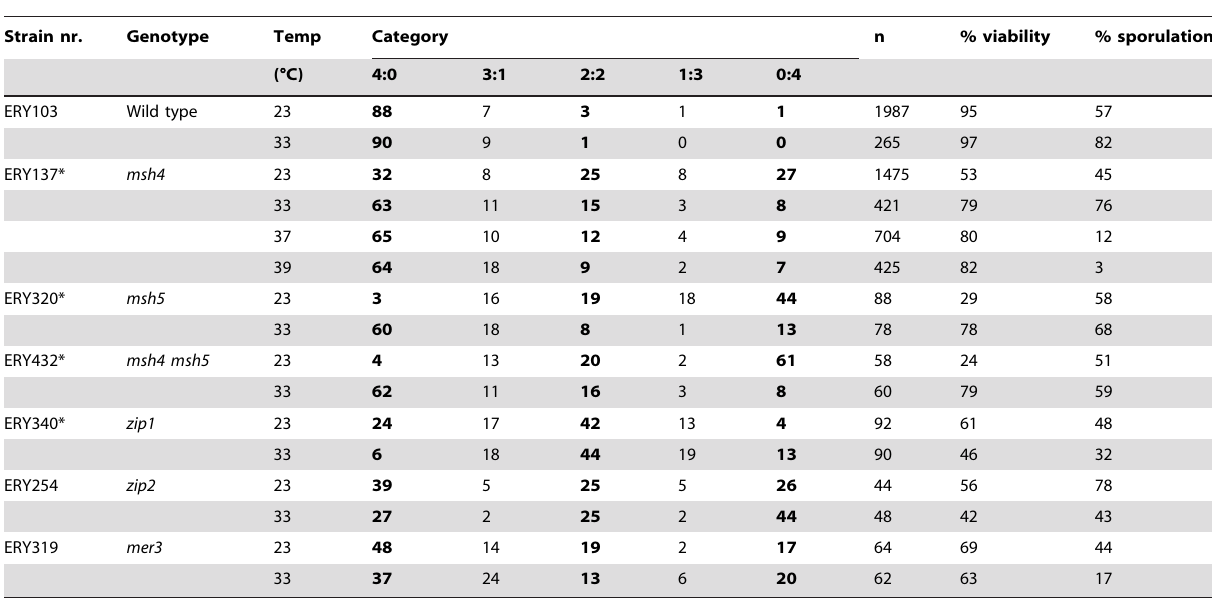
Table 1. Gamete viability and sporulation frequencies in zmm mutants of Y55.